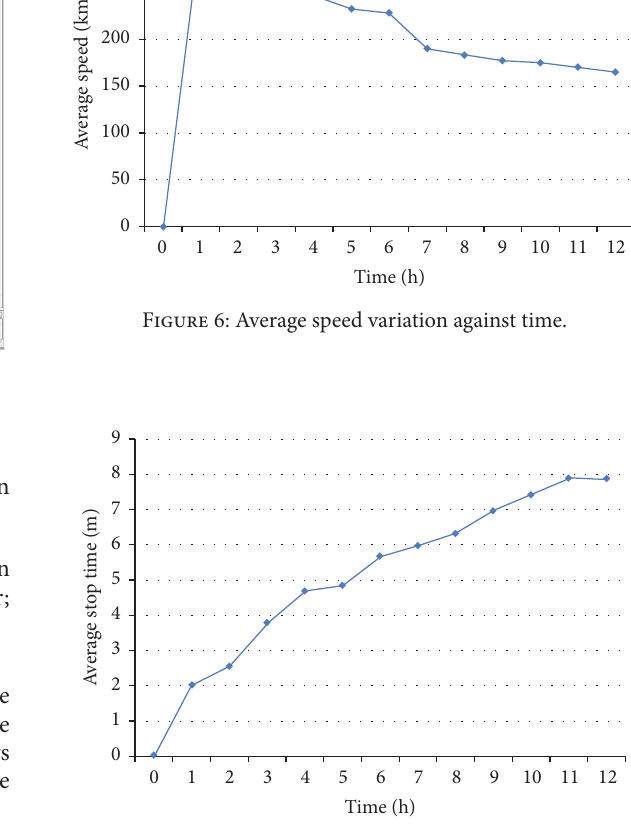
Figure 7: Average stop time variation against